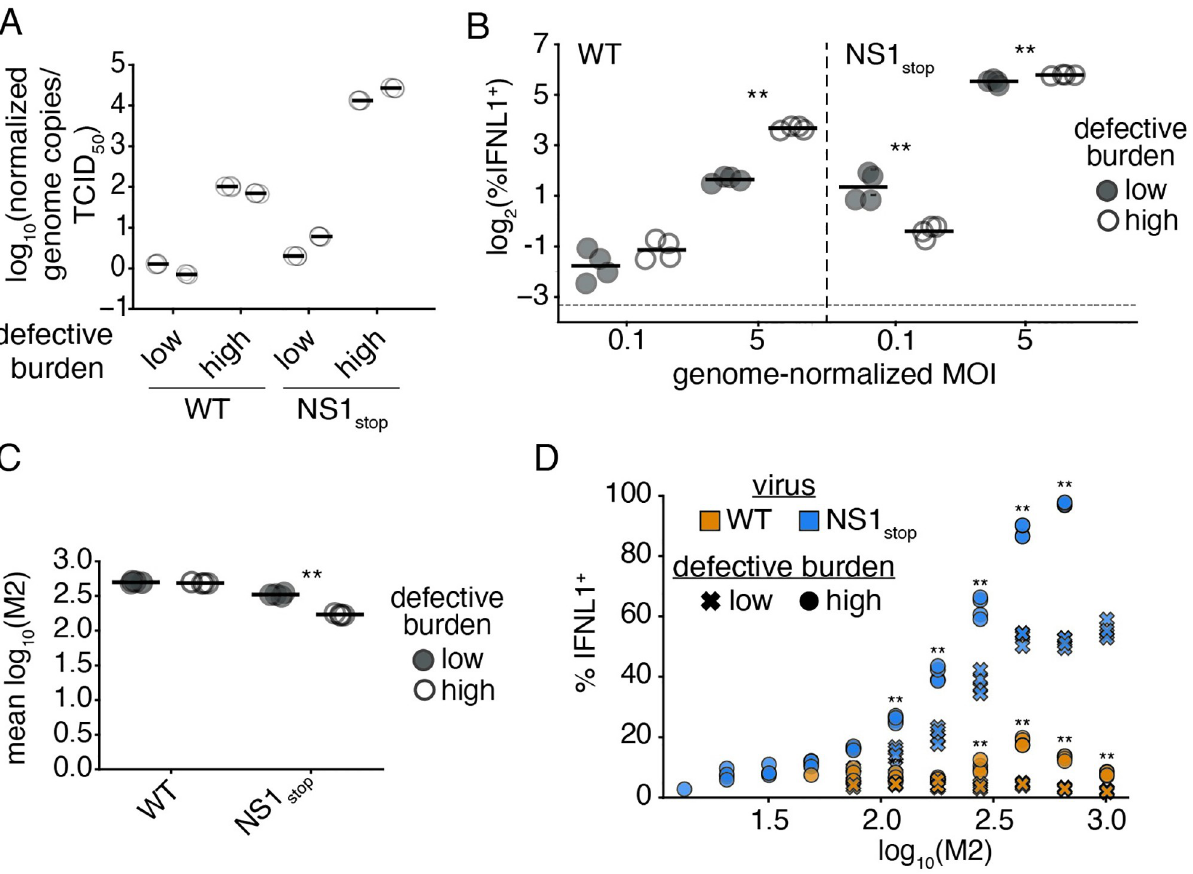
Fig 4. The impact of deletions on interferon in an NS1 stop infection is dose-dependent. (A) Normalized genome copies to infectivity ratio in indicated populations. Genome copies were measured by a qPCR targeting the PA segment in a region retained in deletions. Infectivity was measured by tissue-culture infectious dose 50 (TCID 50 ). The ratio of these values was set to 1 (0 on a logarithmic scale) for the average measurement across our wild-type low-defective populations, and then all values were calculated relative to that reference. High defective burden populations confirmed to have a greater genome copy to infectivity ratio. Individual points indicate technical triplicates, adjacent sets under the same heading represent biological duplicates. (B) Percentage of total cells expressing interferon when IFNL1-reporter cells are infected with the indicated populations at the indicated genome-corrected MOI, as measured by flow cytometry at 13hpi. MOI was calculated on low-defective populations, then an identical number of genome copies were added as measured in A . Asterisks denote significant differences between high- and low-defective populations, two-tailed t test with Benjamini-Hochberg multiple testing correction at an FDR of 0.05, n = 4, two replicates of each of the biological replicate populations shown in A . Detection threshold, as defined by the reporter response in uninfected cells, denoted by the dotted line. Full flow data shown in S12 Fig. (C) Mean fluorescence intensity of M2 staining in the indicated populations from B . Asterisks denote significant differences between high- and low-defective populations, two-tailed t test with Benjamini-Hochberg multiple testing correction at an FDR of 0.05, n = 4. Full distributions shown in S13 Fig. (D) Interferon positivity in MOI 5 infections from B , divided into bins of M2 expression. Asterisks indicate significant differences between high- and low- defective populations within a viral variant. Two-tailed t test with Benjamini-Hochberg multiple testing correction at an FDR of 0.05, n = 4. Statistics only calculated, and points displayed for M2 bins with greater than 100